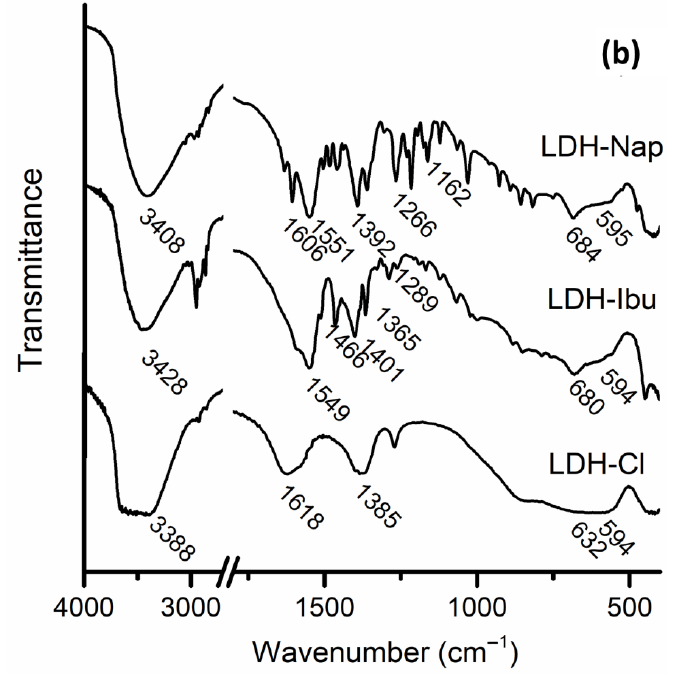
Figure 1. FT-IR spectra ( a ) and PXRD patterns ( b ) of LDH-Cl, LDH-Ibu and LDH-Nap samples. Table 1. Chemical analysis and proposed formula for the synthesized LDH–drug samples. The FT-IR spectra showed characteristic peaks in both the LDH structure and the intercalated drugs (Figure 1b). The band centered at 3428 and 3408 cm −1 for LDH-Ibu and LDH-Nap, respectively, was assigned to the O- H stretching mode (ν OH ) of OH - anions and H 2 O water molecules. The bands recorded at wavenumbers below 1000 cm −1 , especially those at 594–595 cm −1 , were assigned to the lattice vibrations of the LDH layers [32,33]. The band corresponding to the bending vibration of structural water molecules between